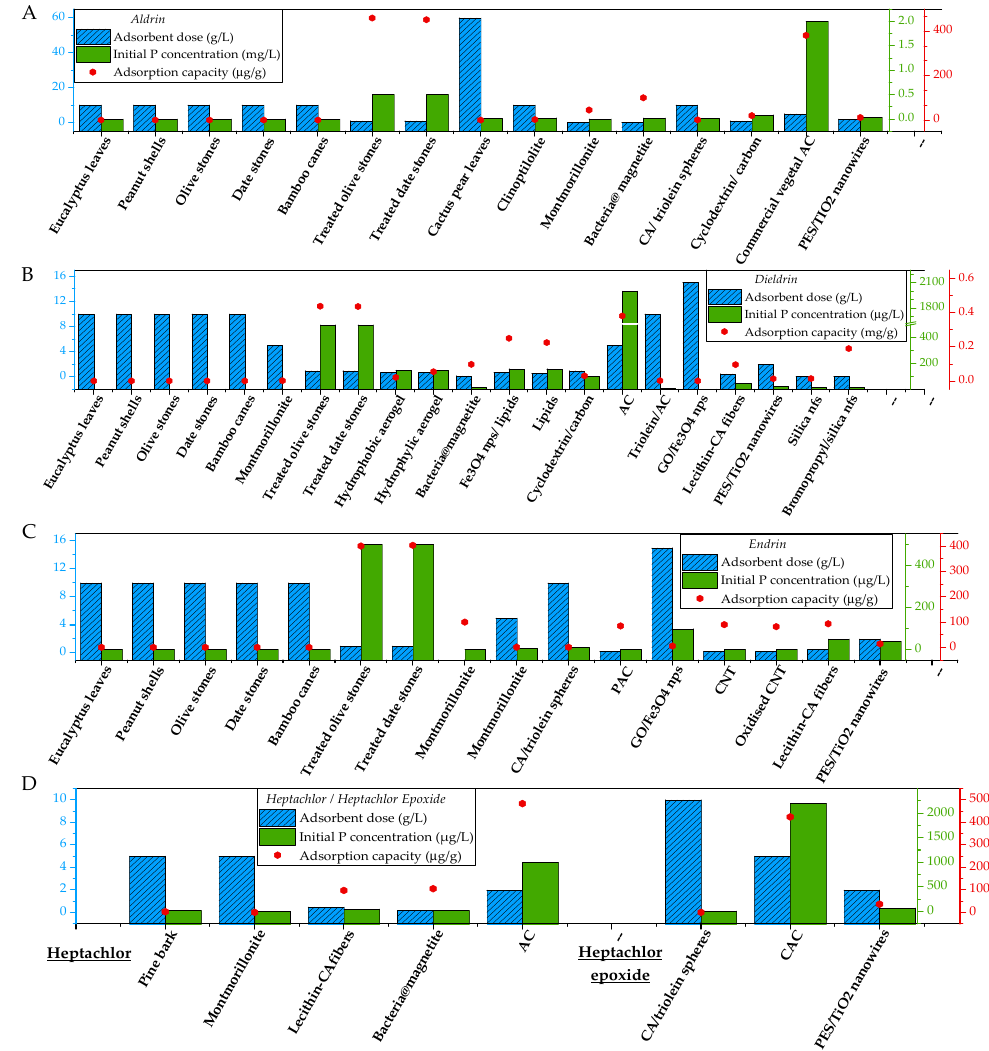
Figure 10. Relationship between adsorbent dose (blue column, left scale), initial pesticide concentration (green column, middle right scale) and adsorption capacity (red scatter, far left scale) in the adsorption of Aldrin ( A ); Dieldrin ( B ); Endrin ( C ); and Heptachlor/epoxide ( D ). Insufficient data reported for Chlordane and Toxaphene.